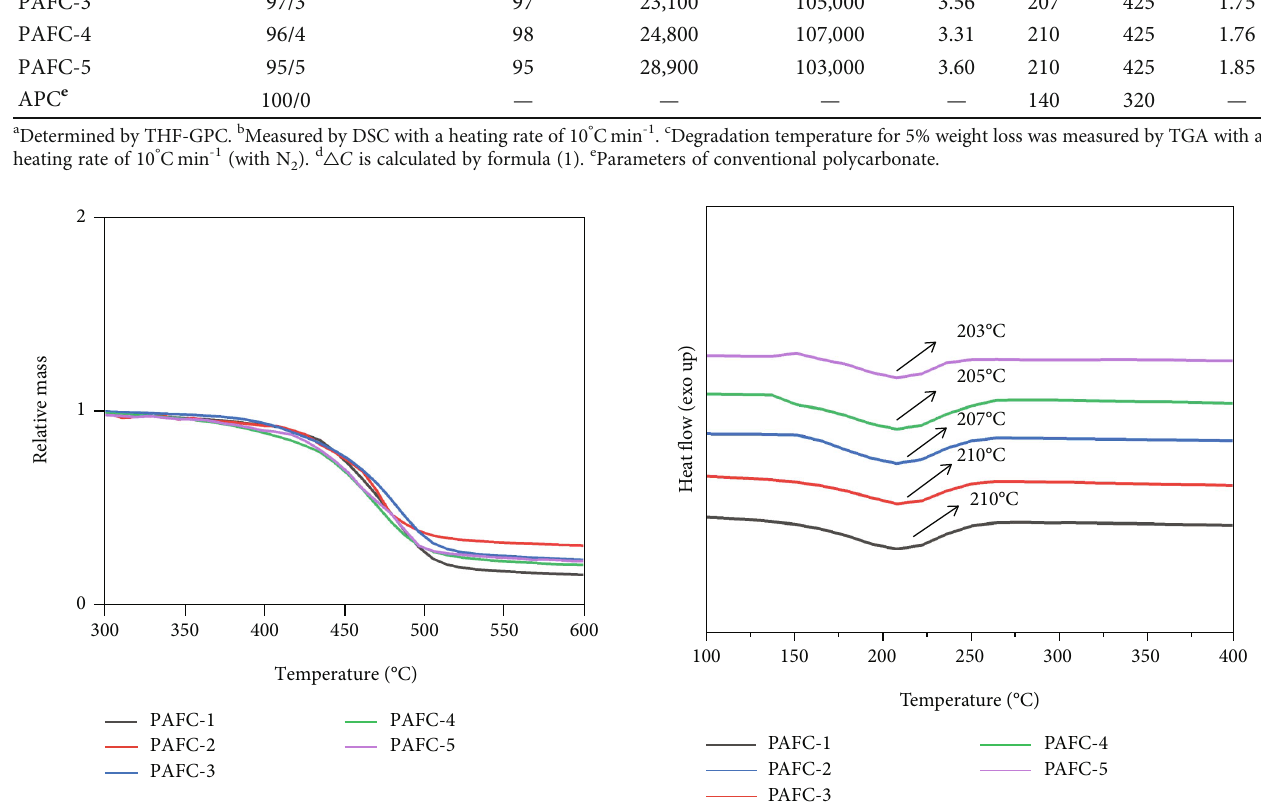
Figure 3: TGA curves of PAFCs.